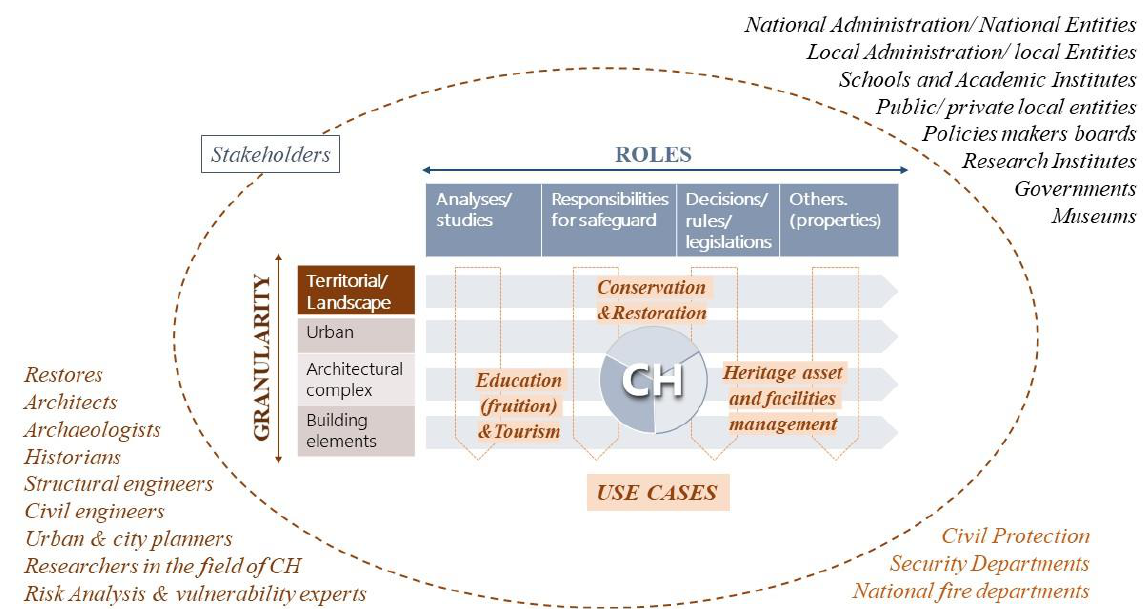
Figure 2. A possible graphical view of communities involved in specific use cases and the grid of parameters concerning roles and granularity considered in the complex action undertaken in CH domain Documentation and heritage studie s is not an unexplored domain either (e.g. Hois et al., 2009 about the architectural and built heritage and also the more general heritage conceptualizations consider this as one of the most important goals), but a lot of potential about specific developments is still there. Regarding heritage risk prevention, not an ontology, but a specific data model was proposed starting from standardised structures and vocabularies within the ResCult project (Chiabrando et al.,